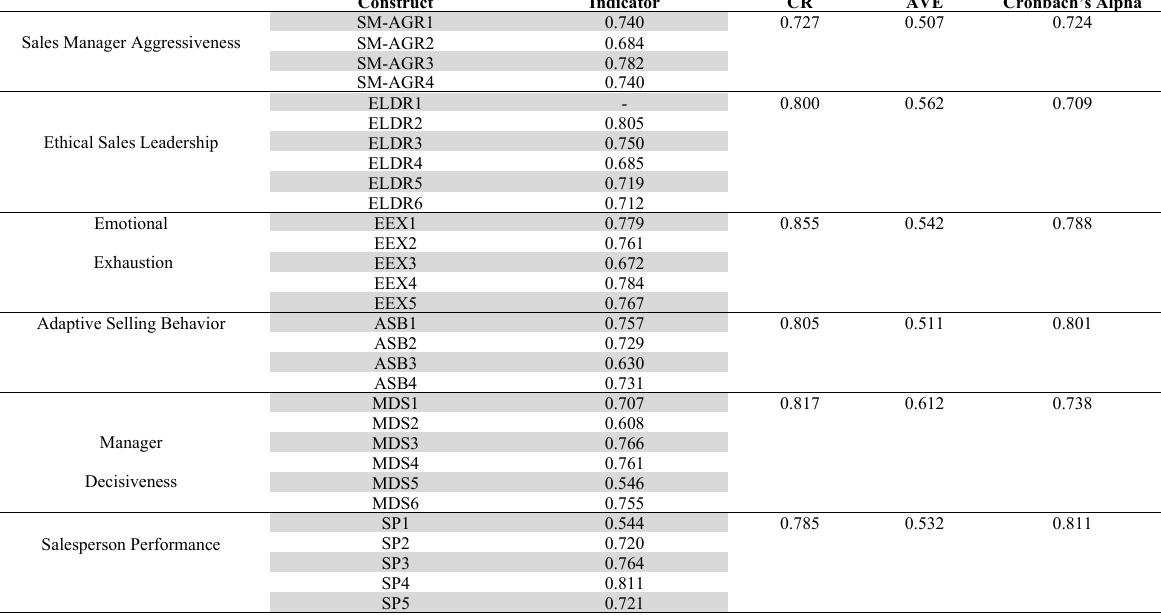
Standardized loading values and constructs’ reliability